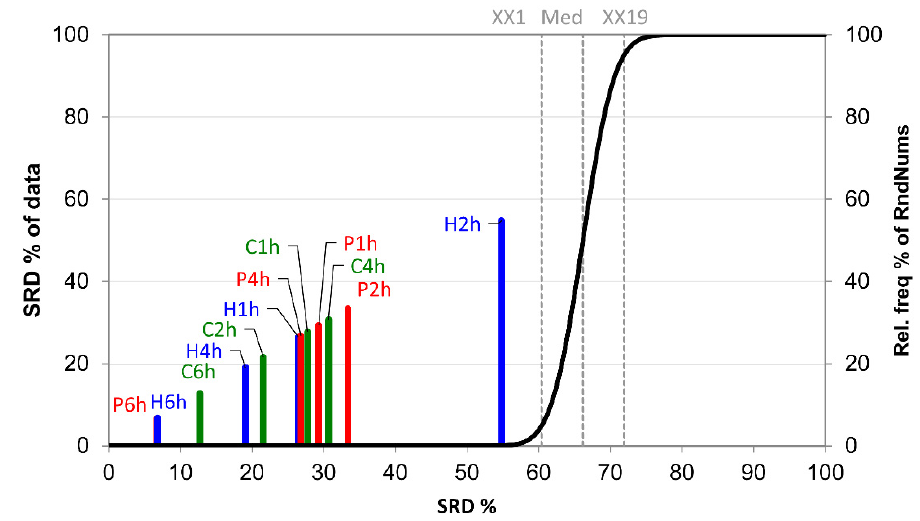
Figure 1. The scaled SRD values of the sampling procedure based on integrated peak area by sum of ranking differences. The maximum values of the compounds (Max) were used as the reference (benchmark) column. Scaled SRD values are plotted on the x-axis and left y-axis; the right y-axis shows the relative frequencies (black curve). Probability levels of 5% (XX1), median (Med), and 95% (XX19) are also given. If a model crosses the cumulative distribution function (XX1), say at p = 0.10, then the method ranks the variable as random with a 10% chance. Diagrams were produced by compound intensity values on a total ion chromatogram ( n = 149).